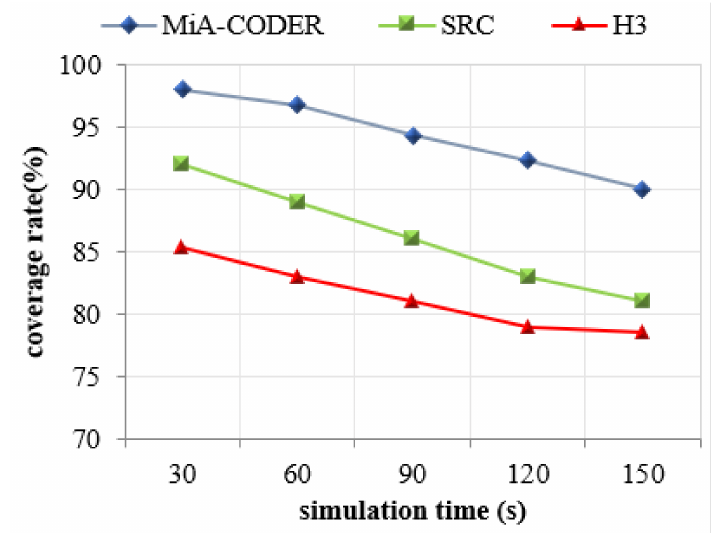
Figure 6. Simulation time vs. coverage rate.